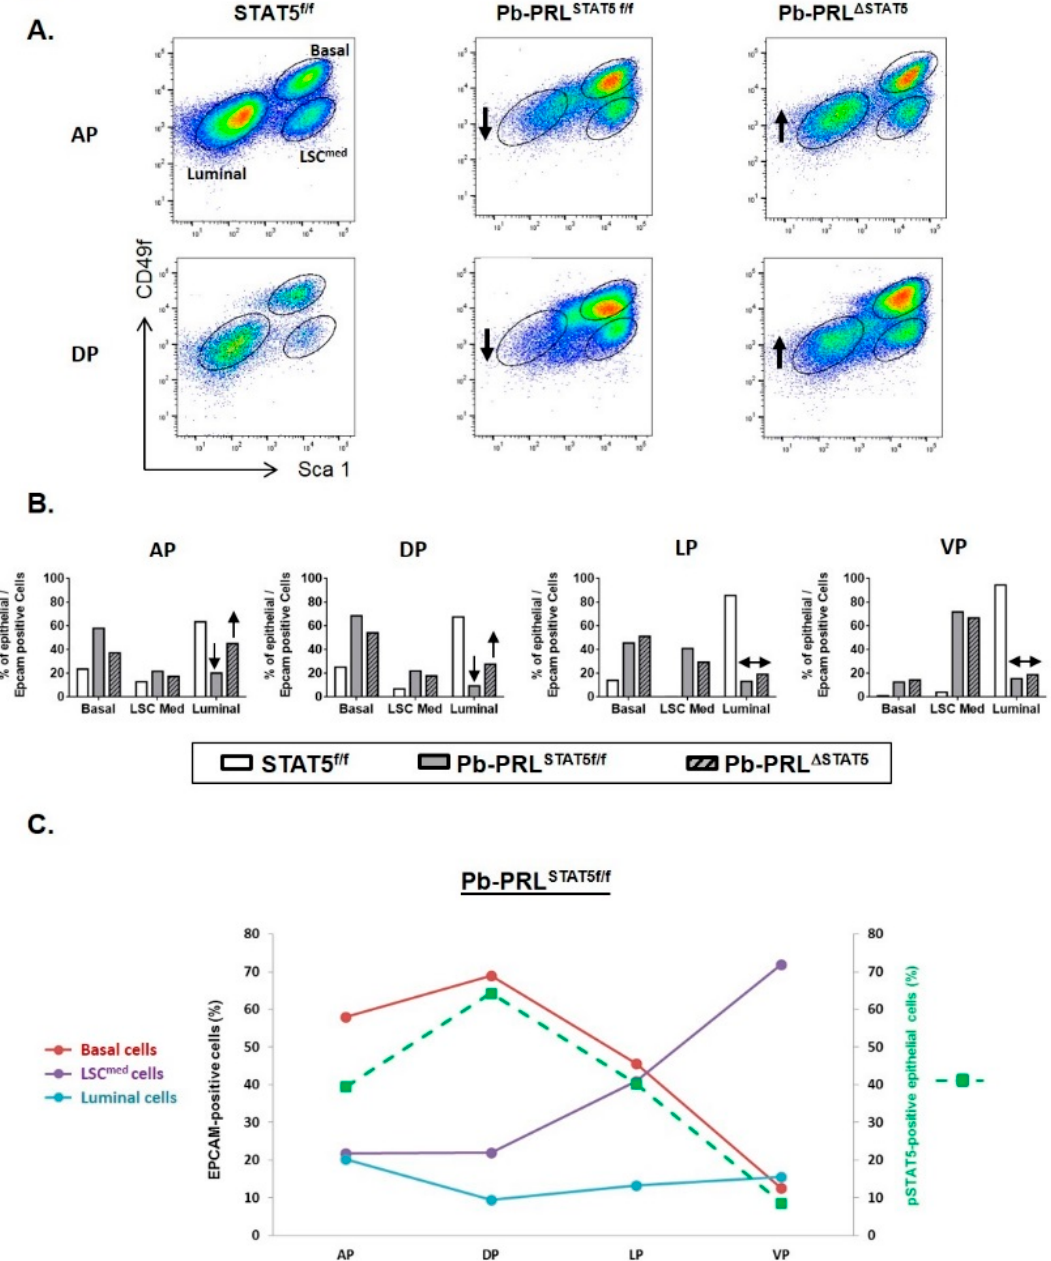
Figure 3. STAT5 deletion alters epithelial cell hierarchy in 6 month-old Pb-PRL ∆ STAT5 mice. ( A ). Representative FACS profiles of anterior (AP) and dorsal (DP) prostate lobes from STAT5 f / f , Pb-PRL STAT5f / f and Pb-PRL ∆ STAT5 mice (3–6 animals per genotype). Graphs depict epithelial cells only (gated as Lin- / Epithelial cell adhesion molecule (EPCAM) + ), with large gates for percentage analysis. Each FACS profile shows gated epithelial populations: basal / stem (LSC high ), LSC med and luminal cells. ( B ). Quantification of the three cell populations in the four prostate lobes from the three genotypes is shown. In panels A and B, the arrows indicate the loss of luminal cells in Pb-PRL STAT5f / f versus STAT5 f / f mice, and their partial rescue in anterior and dorsal prostate of Pb-PRL ∆ STAT5 mice (no similar e ff ect was observed in the two other lobes). ( C ). For each prostate lobe of Pb-PRL STAT5f / f mice, the percentage of the three epithelial cell populations was plotted versus the level of STAT5 phosphorylation, as determined in Figure 1G.